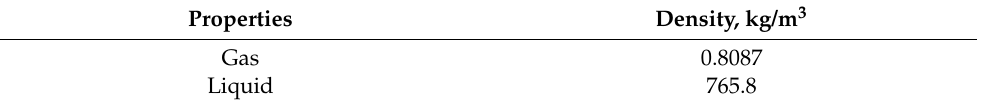
Fluid properties table (Table 3): Table 3. Fluid properties.